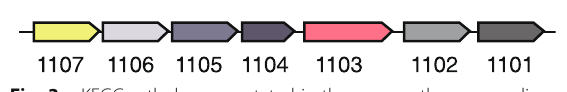
Fig. 3 a KEGG orthologs annotated in the gene pathway